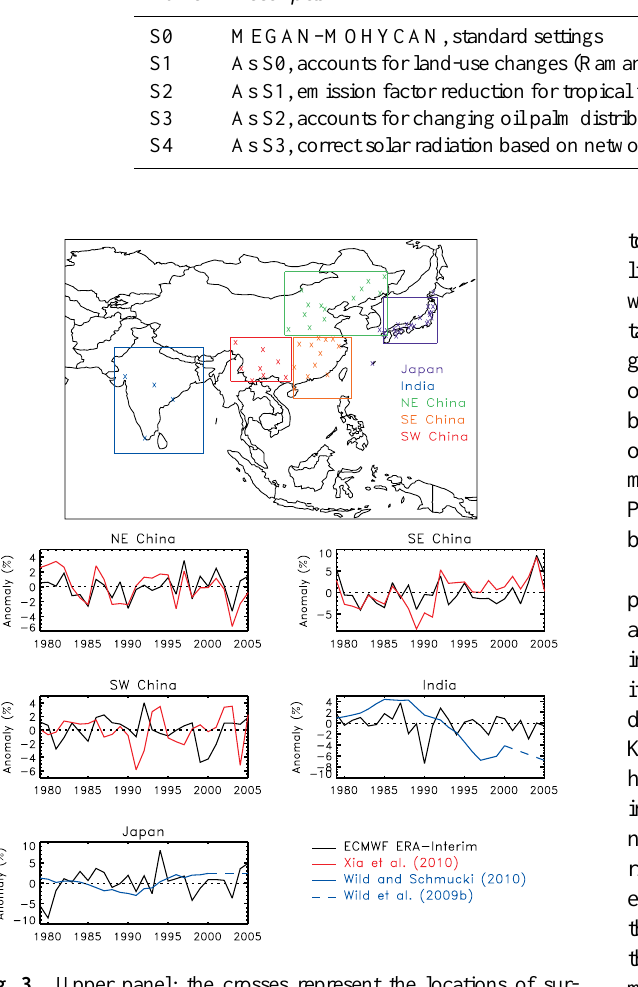
Fig. 3. Upper panel: the crosses represent the locations of sur- face radiation measurement stations in China, Japan and India, as reported in Xia (2010); Wild and Schmucki (2010). Lower panel: annual downward surface solar radiation (SSR) anomaly (in %) derived from ERA-Interim fields (black) and corrected based on ground-based SSR observations in China (Xia, 2010), India and Japan (Wild and Schmucki, 2010; Wild et al.,